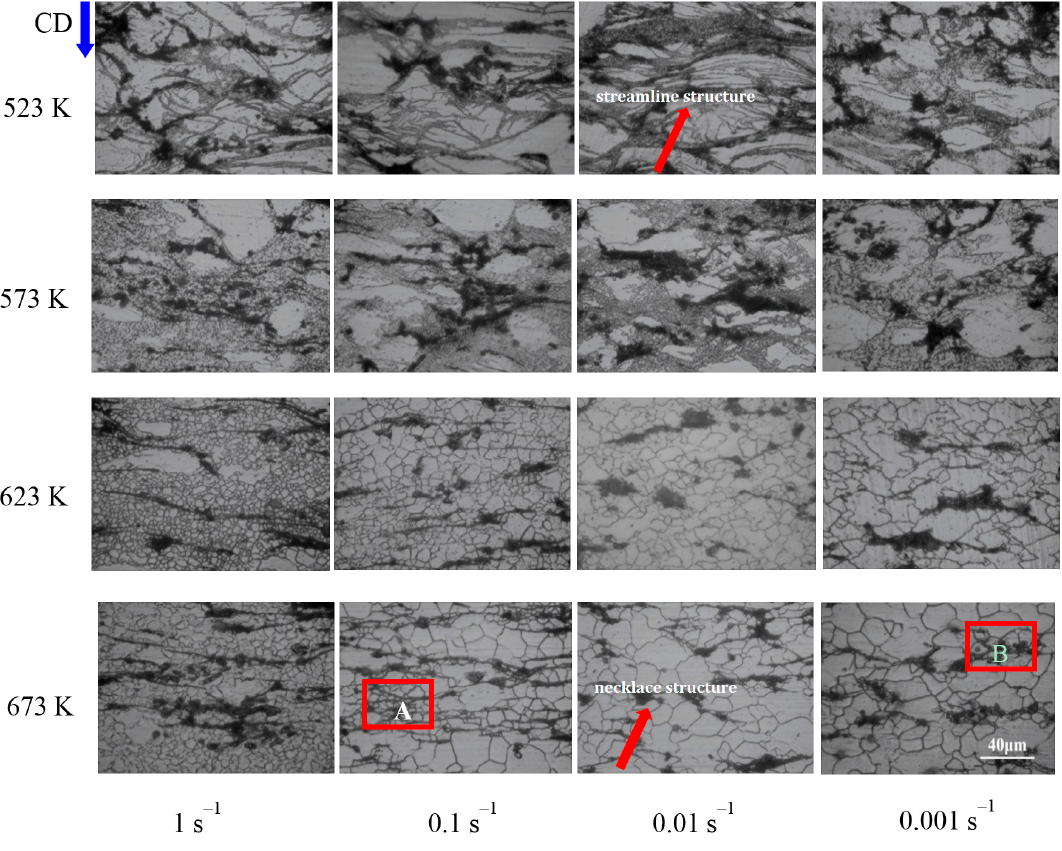
Figure 3. OM images of nano-SiCp/AZ91 composite after hot compression. (CD represents compression direction, red arrows indicate necklace structure; rectangular red areas “A” and “B”represent the grains away from SiC nanoparticles).